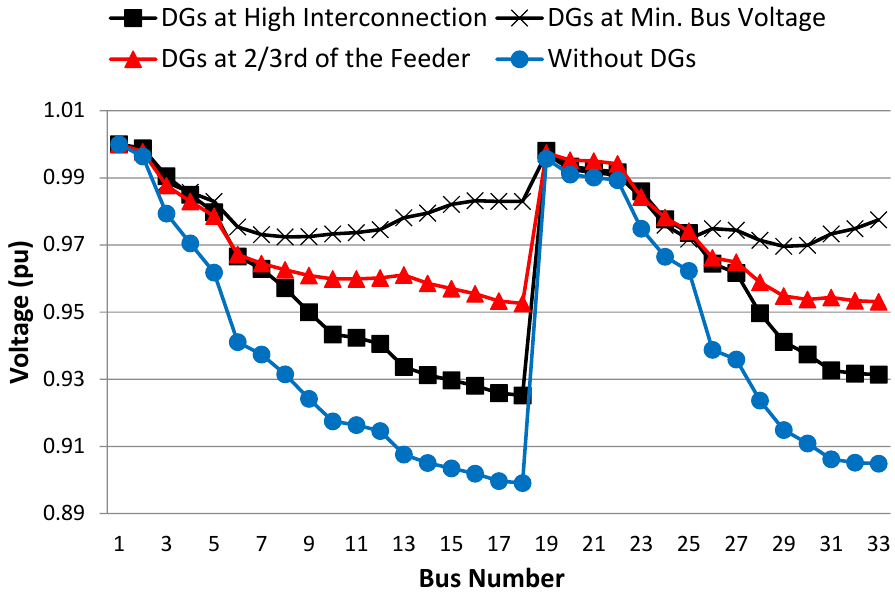
Figure 9. The voltage profile at 100% loading condition.